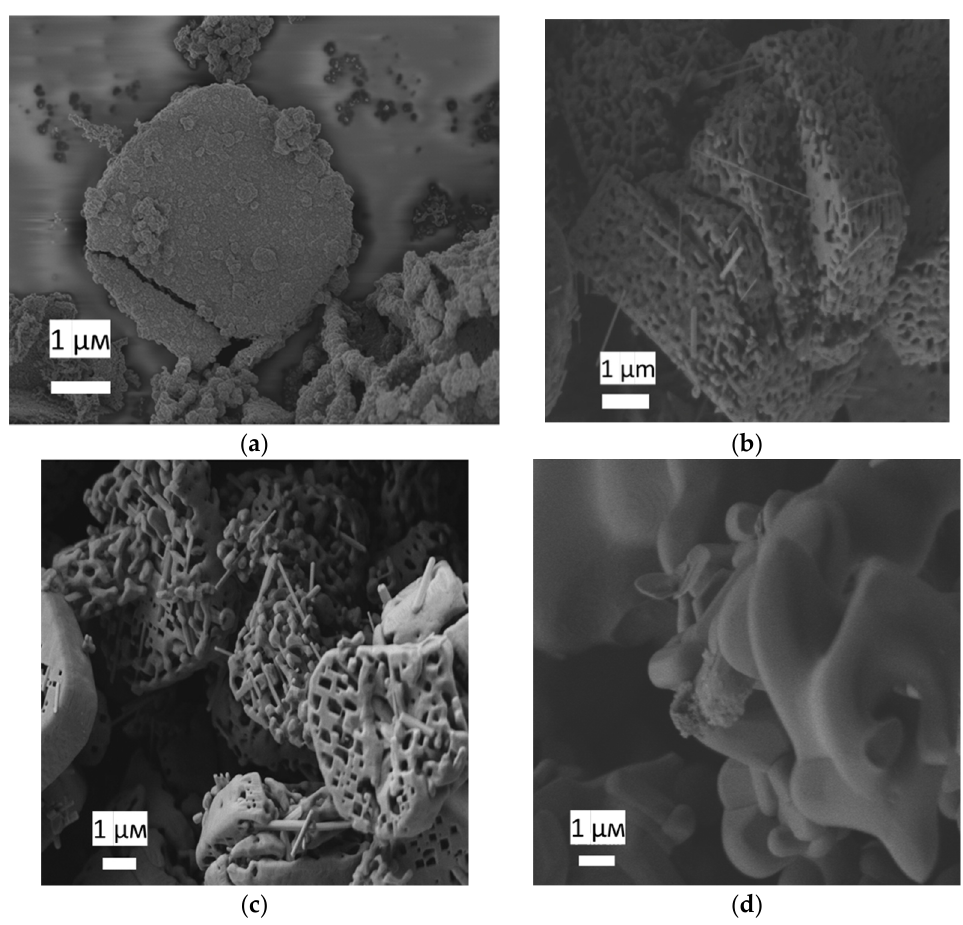
Figure 5. Scanning electron micrographs of a sample of TiO 2 mesocrystals generated from a sample of NH 4 TiOF 3 by heating under air ( a ) at 600 °C, ( b ) at 800 °C, ( c ) at 1000 °C and ( d ) at 1200 °C (white scale bar = 1 µm).